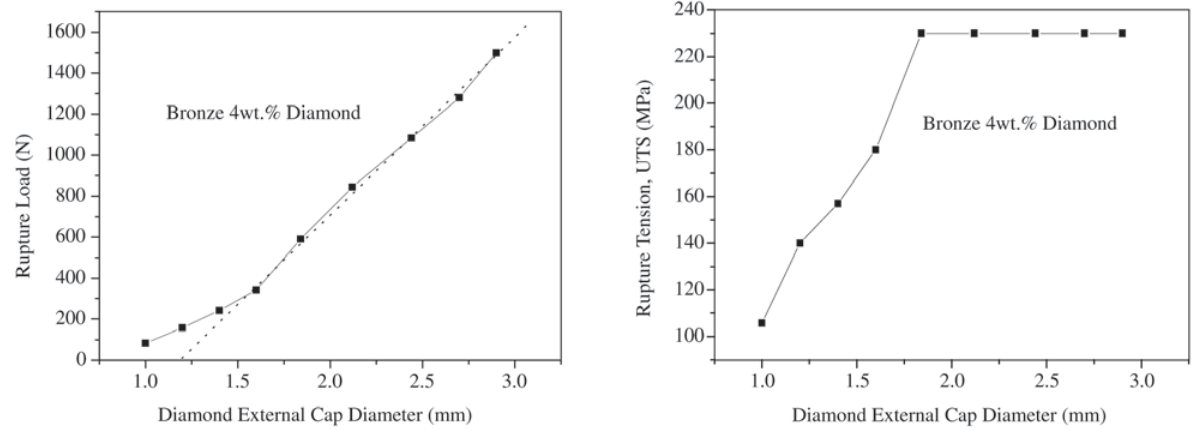
Figure 3. (a)Rupture load (N) as a function of diamond external cap diameter (mm), and (b) rupture tension (UTS) as a function of diamond external cap diameter